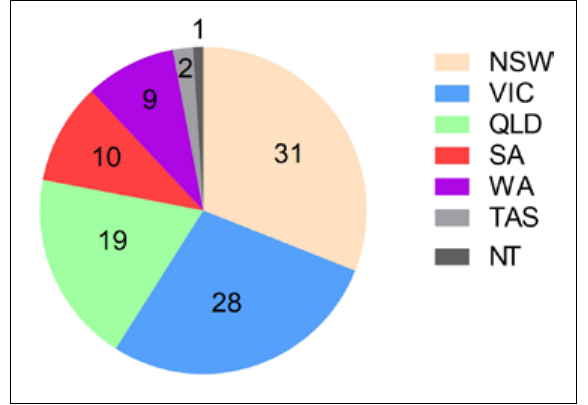
Figure 3. State distribution of respondents (percent).